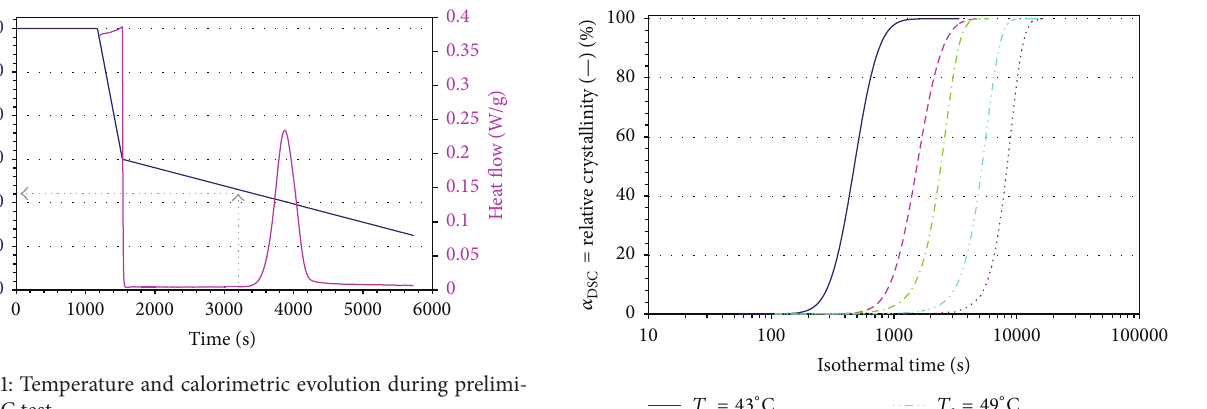
(𝑡) defined by (1)) DSC